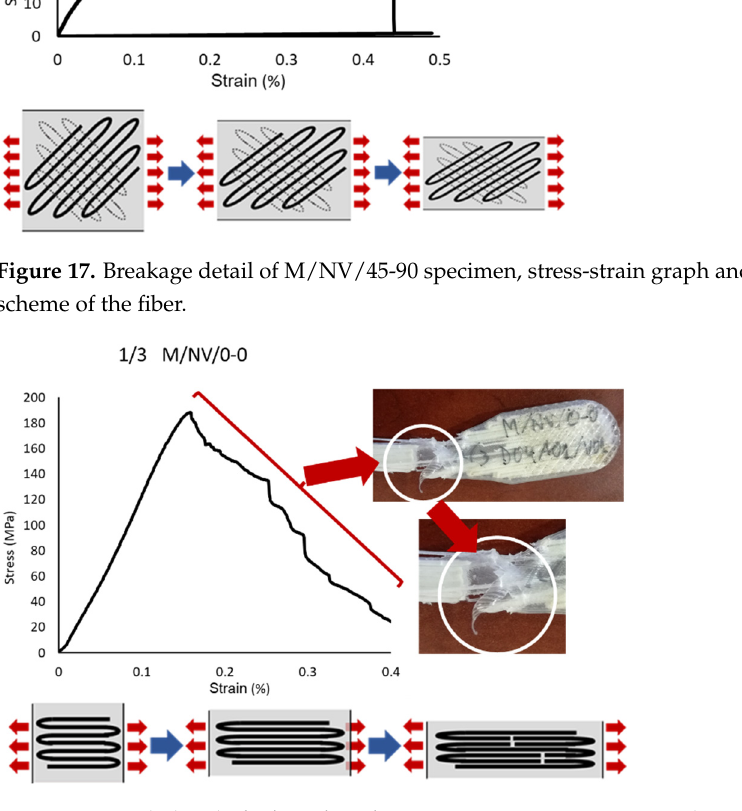
Figure 18. Break detail of 1/3 M/NV/0-0 specimen: stress-strain graph and drawing and breaking behavior scheme of the fiber.